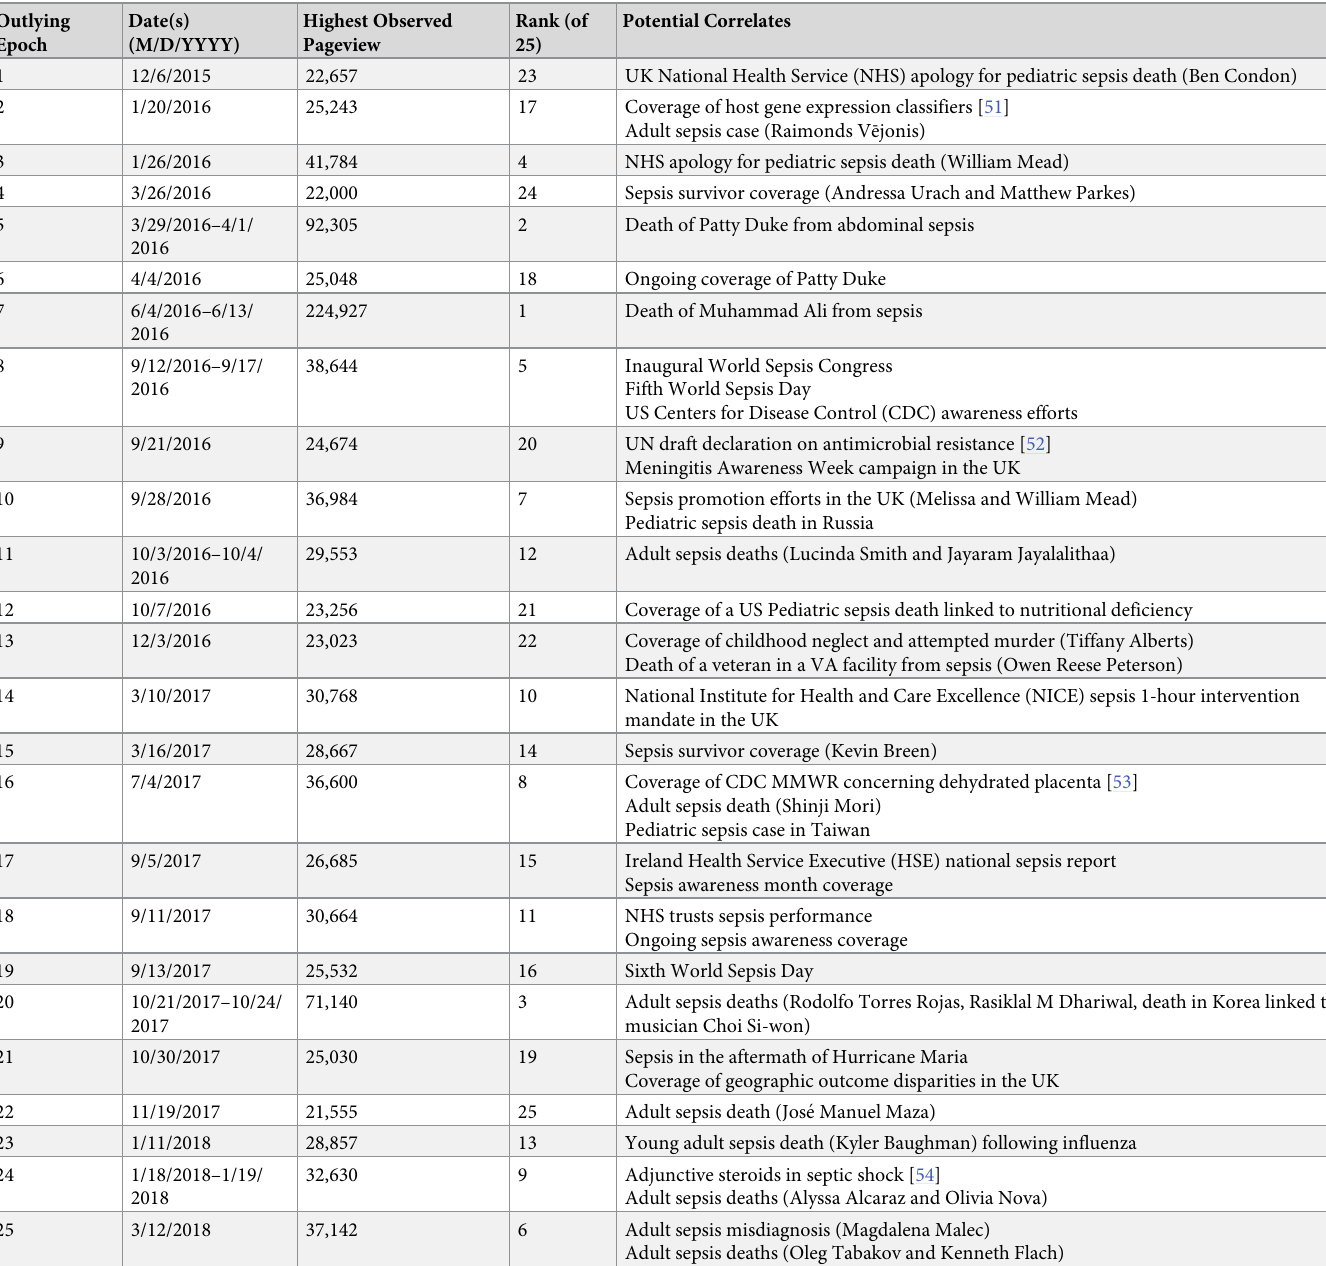
Data extraction spanned July 1, 2015 to June 30, 2018. The highest pageview count per aggregated epoch is depicted and its rank